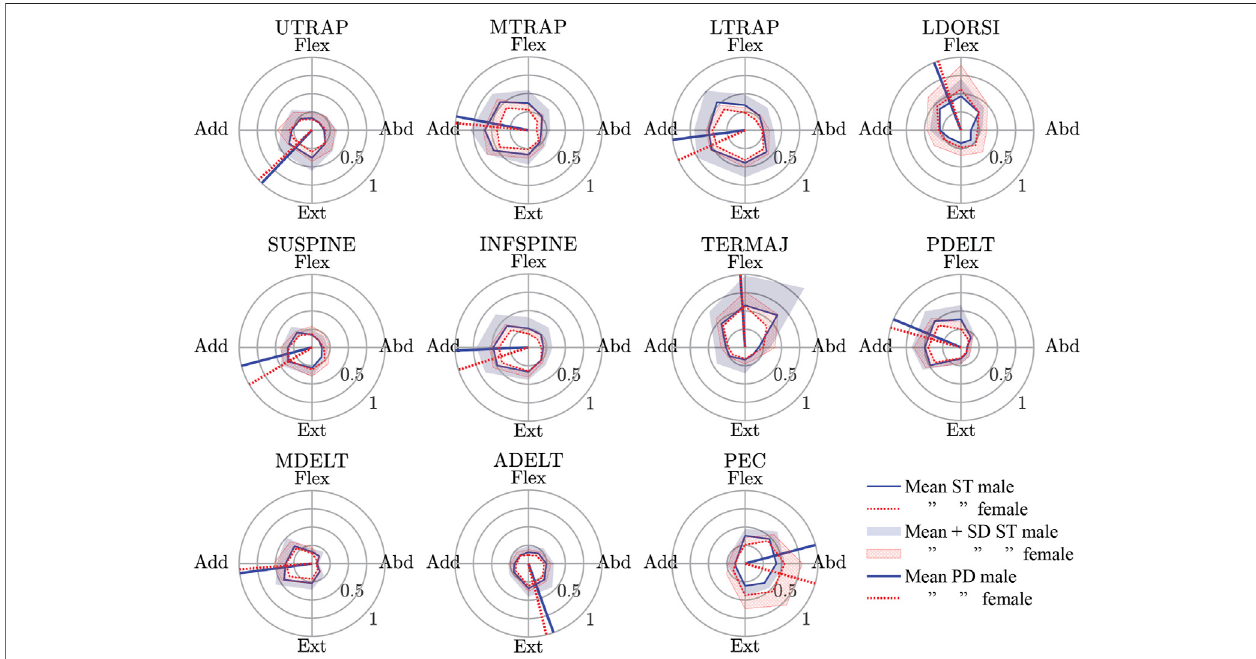
FIGURE 4 | Male and female spatial tuning patterns (STP) for each muscle studied. STP is a polar plot of the normalized muscle activity (rho) as a function of the eightnominalloadingdirections (theta). ThemeanSTPforboth sexes areshown alongwiththemean + 1standard deviation ofmuscle activity ineach loadingdirection. Finally,thepreferredactivation directions(avector averageofthepoints inthemeanSTP)arealsoshown.See Table2 foradescriptionofthemuscleshort forms.Flex., Flexion; Abd., Abduction; Ext., Extension; Add., Adduction.